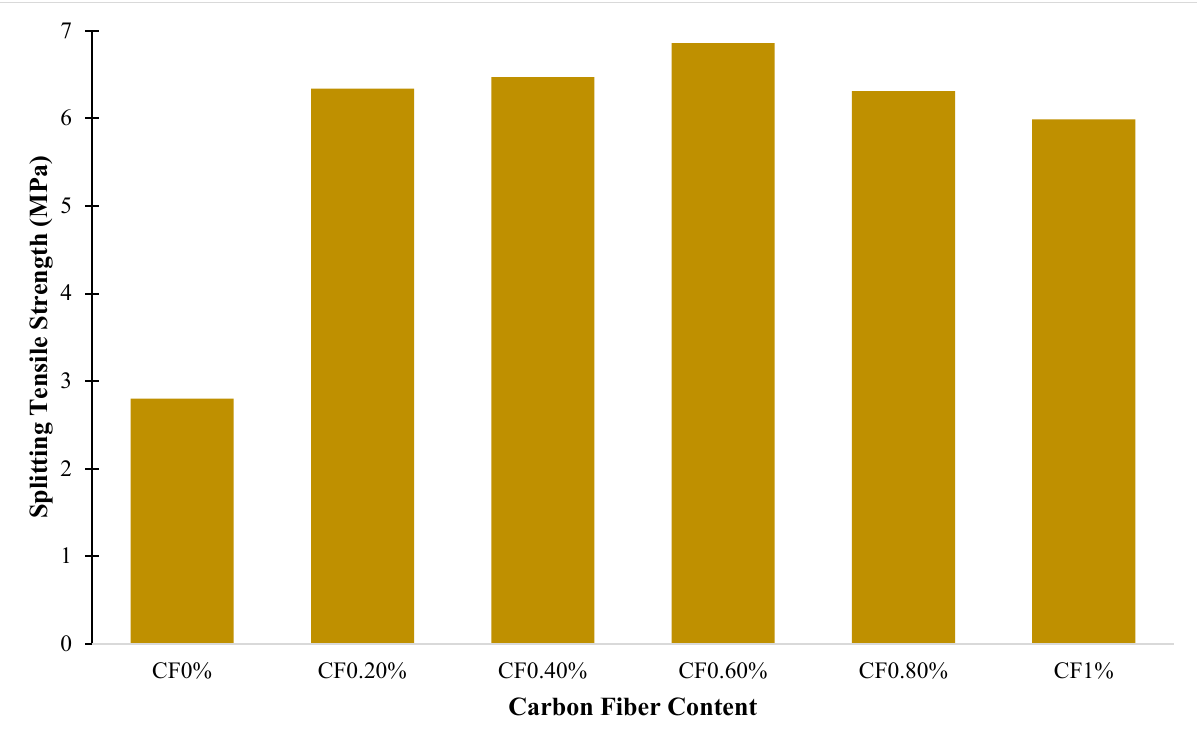
Figure 7. Split tensile strength.